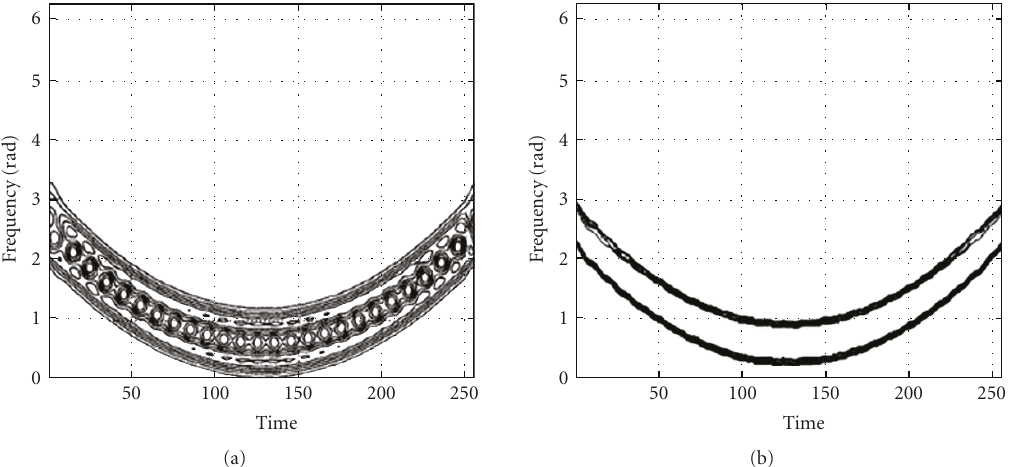
Figure 1: Example 1. A signal consisting of two closely spaced quadratic FM components, (a) initial ES estimate of the signal, (b) the final ES estimate (adopted from Akan